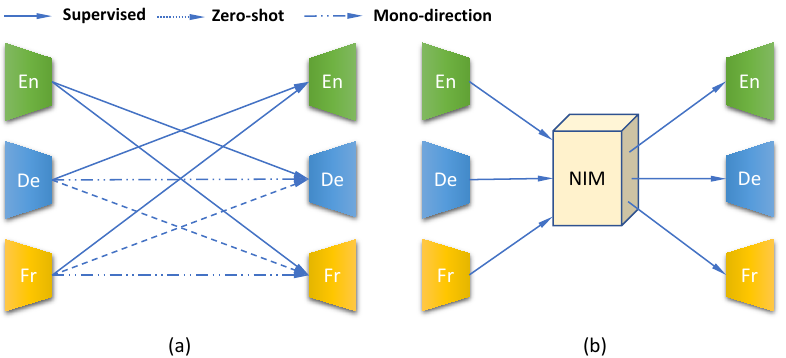
Figure 6. The two steps of the framework for rectifying ill-formed interlingua of the M2 model trained in the JM2M environment. ( a ) Adding mono-direction translation ( b ) Incorporating a neural interlingual